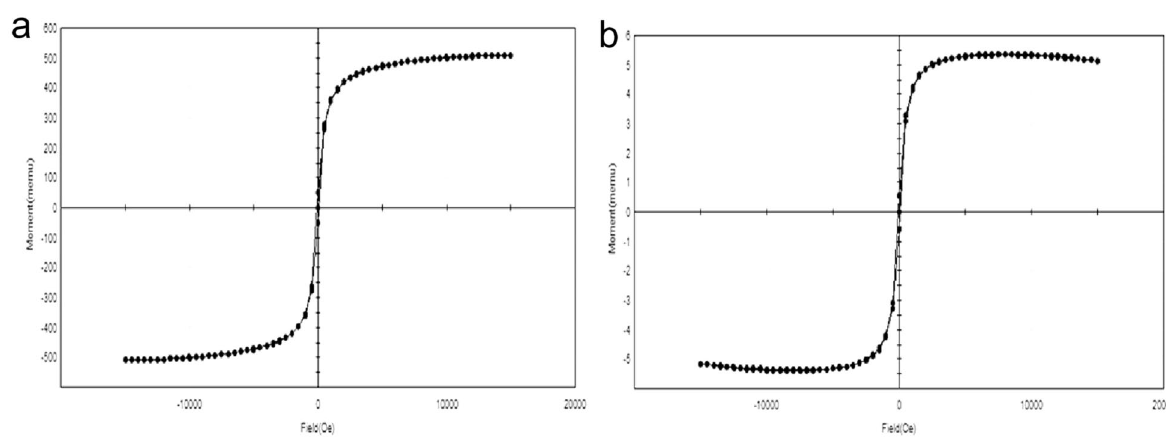
Figure 6. VSM of ( a ) SPIONs; ( b ) Latex coated